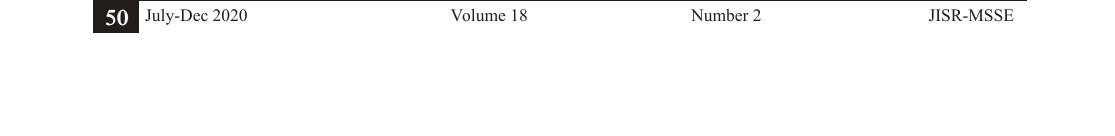
Figure 1: Scatter Plot of determinants of Tourism